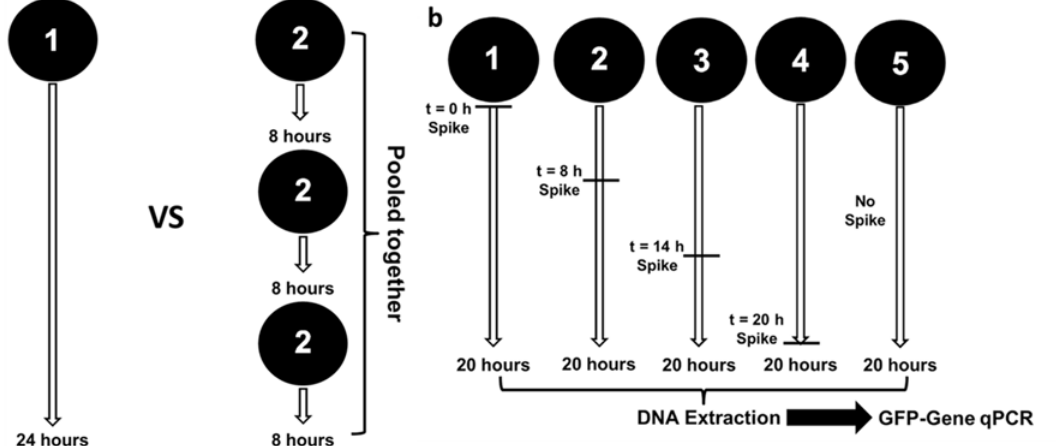
Fig 1. Sampling duration experiments for microorganisms collected on filters. (a) – Comparison of 1×24 hour versus 3×8 hour parallel sampling. Two sets of sampling trains collected air at the same time and location for 24 hours. The first set sampled the air continuously for 24 hours on a single filter, while the other set ’ s filter was replaced every 8 hours. DNA extracted from the three 8-h filters was then pooled and the result is compared with the first set which was extracted alone. (b) – Testing loss of GFP-tagged bacteria during sampling . A set of filters sampled air at the same time and location for a total duration of 20 hours. Known quanta of GFP-tagged S . oneidensis cells were spiked onto the filters at staggered timepoints, exposing them to different durations of air